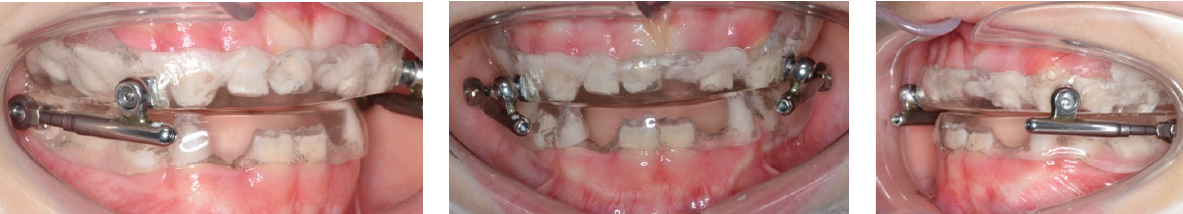
Figure 4. Frontal and lateral views at the beginning of the treatment with Class III PowerScope.